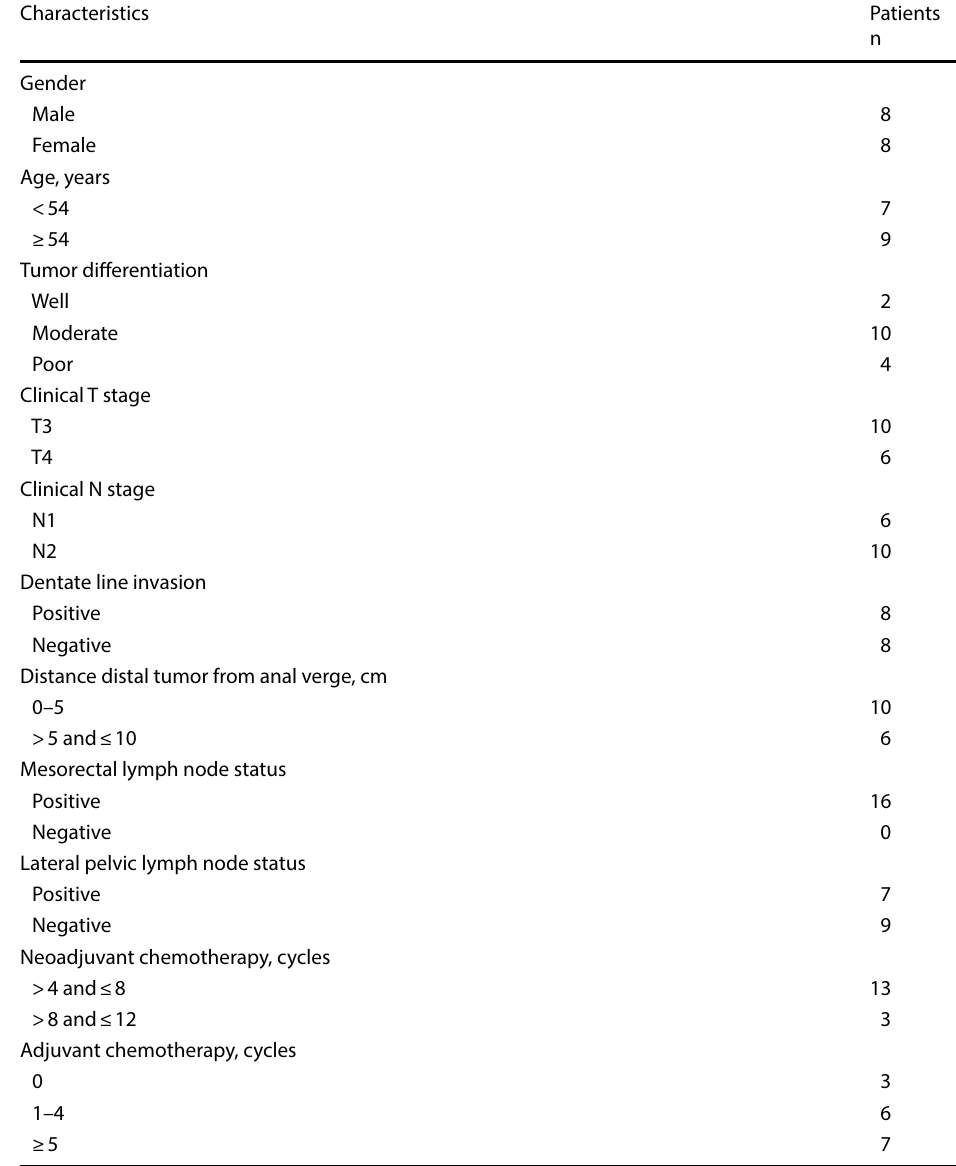
Table 1 Demographic and baseline clinical characteristics of 16 patients with LARC and synchronous